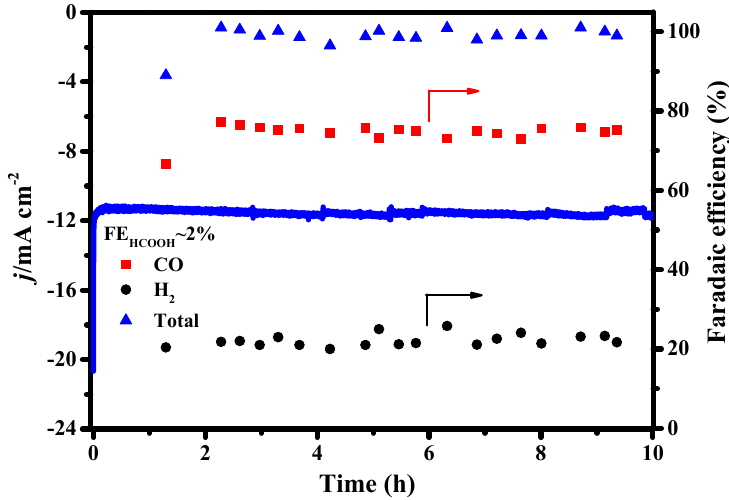
Figure 8. Long-term stability test for A-Cu / SnO 2 (15 min) electrode at − 1.0 V vs. RHE for 10 h in CO 2 -saturated 0.1 M KHCO 3 solution.